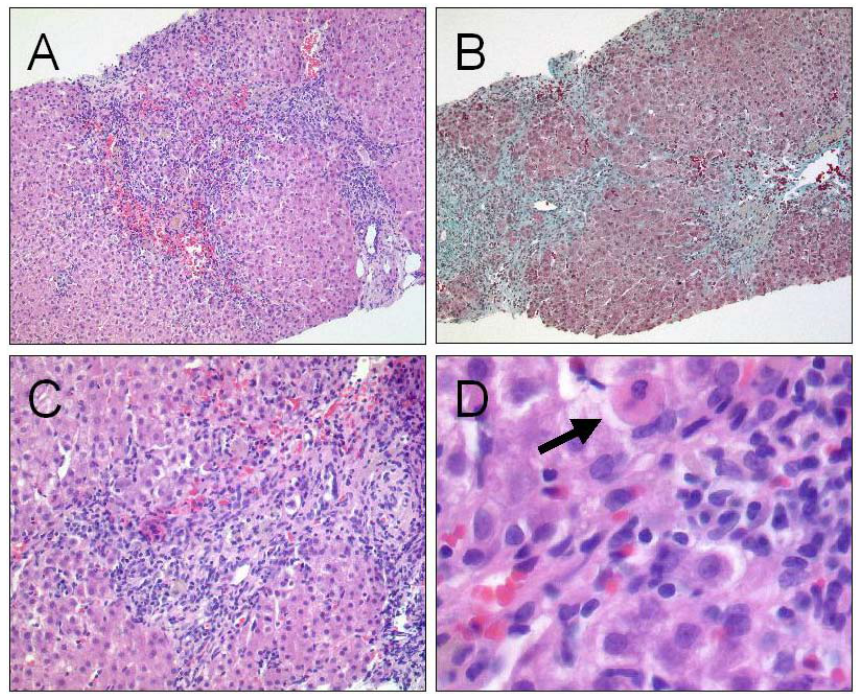
Fig. 1 Histology of patient’s liver biopsy - A still active hepatitis showing the partially organized collapse of the reticulin framework (A), the onset of an irregular fibrosis (B), and the spill-over of lymphocytes and plasma cells in the adjacent liver parenchyma (C) with cuffing of lymphocytes around hepatocytes (D) and single cell necrosis (arrow). A - hematoxylin & eosin, × 100; B - Goldner, × 100; C - hematoxylin & eosin, × 250; D - hematoxylin & eosin, ×